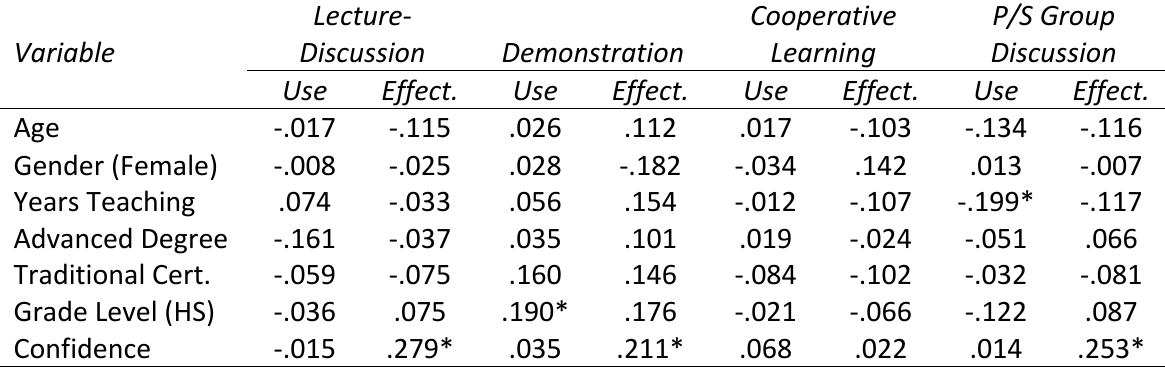
Zero Order Correlations for Teacher Demographics, Confidence Teaching Subject Matter, Method Use, and Belief of Method Effectiveness